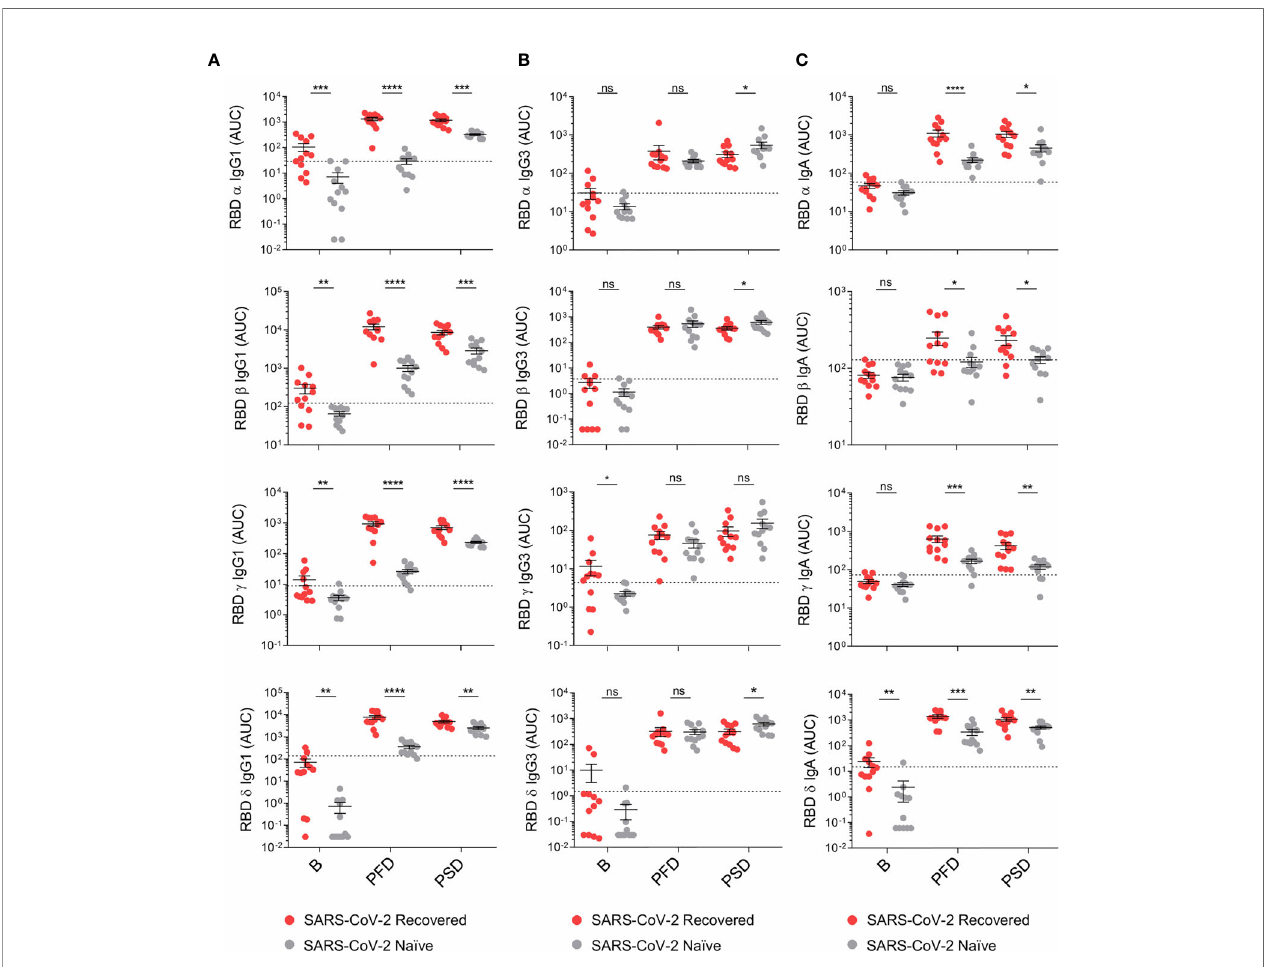
FIGURE 3 | mRNA-1273 vaccination induces increased levels of cross-reactive IgG1 and IgA against the variants of concern in recovered individuals compared to SARS-CoV-2 naïve individuals. (A) AUC for the IgG1, (B) IgG3, and (C) IgA antibodies against the RBD of the a , b , g and d variants analyzed from SARS-CoV-2 naïve and recovered individuals overtime. Sera from SARS-CoV-2 naïve individuals at baseline were used to establish negative threshold values de fi ned as the naïve AUC mean plus 2 times the standard deviation of the mean. Bars represent mean ± standard error mean (SEM). Dashed line indicates negative threshold. Data are presented as individual dots. Two-tailed Mann-Whitney U test was performed to compare SARS-CoV-2 naïve and recovered individuals (ns, not signi fi cant P > 0.05, *P < 0.05, **P < 0.01, ***P < 0.001, and ****P < 0.0001). SARS-CoV-2 naïve, n=12; SARS CoV-2 recovered,